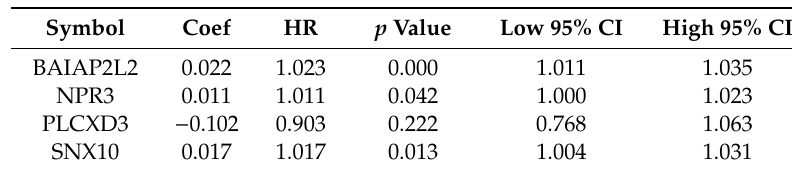
Table 2. 4-DMEGs based signature.